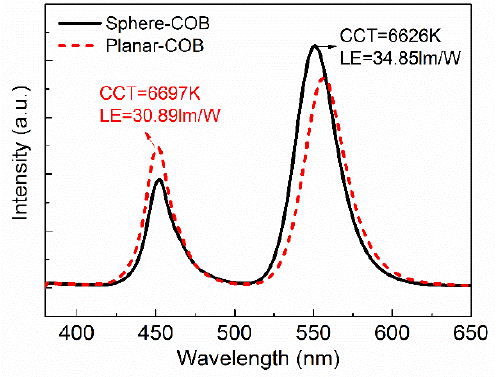
Figure 2. Emission spectra of sphere-(chips-on-board) COB and planar-COB.